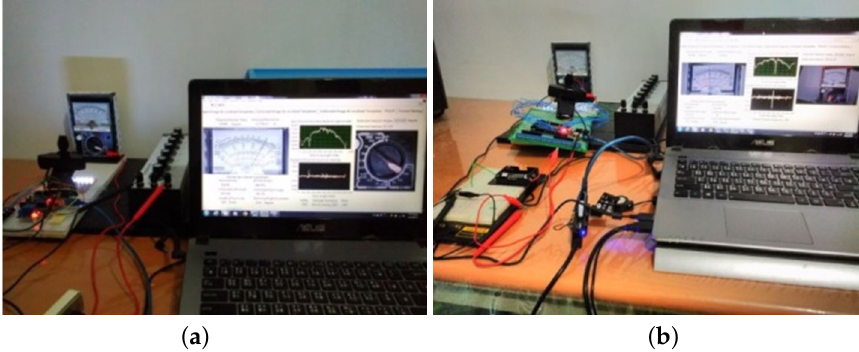
Figure 4. Experimental devices were set up to develop algorithms and verify the capability of reading an A-meter by computer vision. ( a ) A standard resistance box (DC resistance controller ZX99A [20]) was used to output resistance to the probe of the A-meter to build lookup data and measure resistance. ( b ) Measuring the DC current of a 1.5Vdc